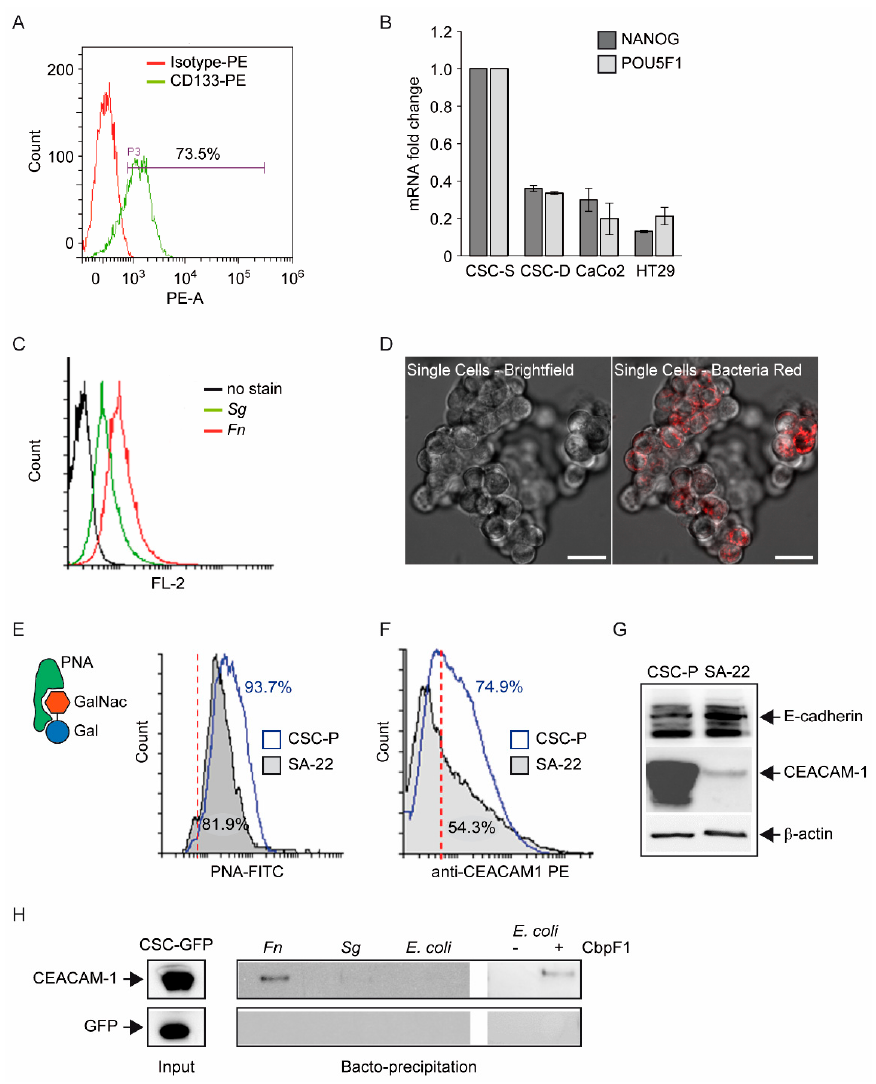
Figure 1. Direct interaction between Fn and spheroidal colon cancer stem cells . ( A ) Flow cytometry analysis for the stem cell marker CD133 in spheroidal CSC-P cells. The percentage of the CD133+ population is indicated. ( B ) Relative expression level of NANOG and POU5F1/OCT4 mRNA in CRC lines CaCo 2 and HT29 compared with primary colonsphere cells (CSC) grown in proliferative (S) or differentiative (D) medium. Values are the mean ± SD of qPCR experimental duplicates. ( C ) Flow cytometry plot of CSC-associated fluorescence following incubation with 100 MOI of red-labeled bacteria. Black trace: baseline; Fn : Fusobacterium nucleatum ; Sg : Streptococcus gallolyticus . ( D ) Representative confocal images of red-fluorescent Fn adhering to freshly dissociated CSCs. Left: phase-contrast image; right: transmittance/fluorescence overlay. ( E ) Flow cytometry plot of FITC-PNA (peanut agglutinin)-stained CSC-P and SA-22 cells. Numbers indicate the % of cells exposing the Gal-GalNac sugar moiety, recognized by PNA. The red dashed line marks the positivity threshold (autofluorescence). ( F ) Single-parameter flow cytometry histogram for surface CEACAM-1 expression in spheroidal cultures of CSC-P and SA-22 cells. Numbers denote the % of cells above the isotype control (vertical dashed line) threshold. ( G ) CEACAM-1 and E-cadherin immunodetection in protein homogenates from CSC-P and SA-22 cells. β -actin serves as a control for equal sample loading. Relevant bands are indicated by arrows. ( H ) Immunoblot analysis of bacteria-adsorbed proteins after 30 min of incubation with homogenates from GFP-transduced CSCs. The input lysate is shown as a positive control for staining. The different bacterial strains used as baits are indicated in italics. Picture representative of 2–3 independent experiments with comparable